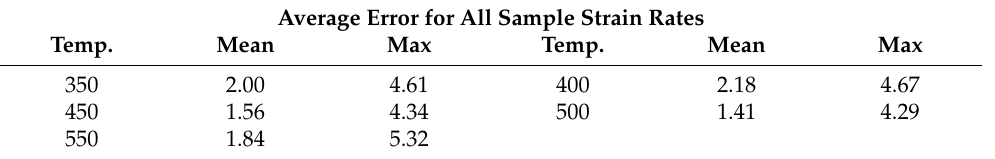
Table 3. Error analysis of the CLSCs predicted by RFCs–BFTCs.